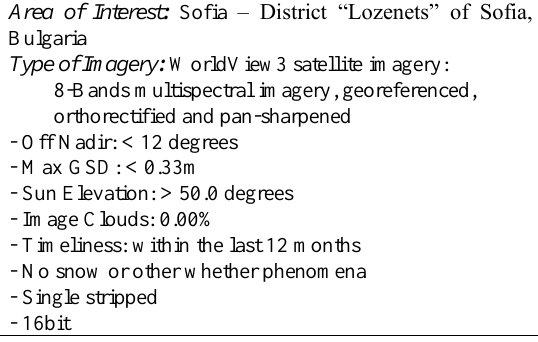
Figure 2. Requirements on the test imagery.